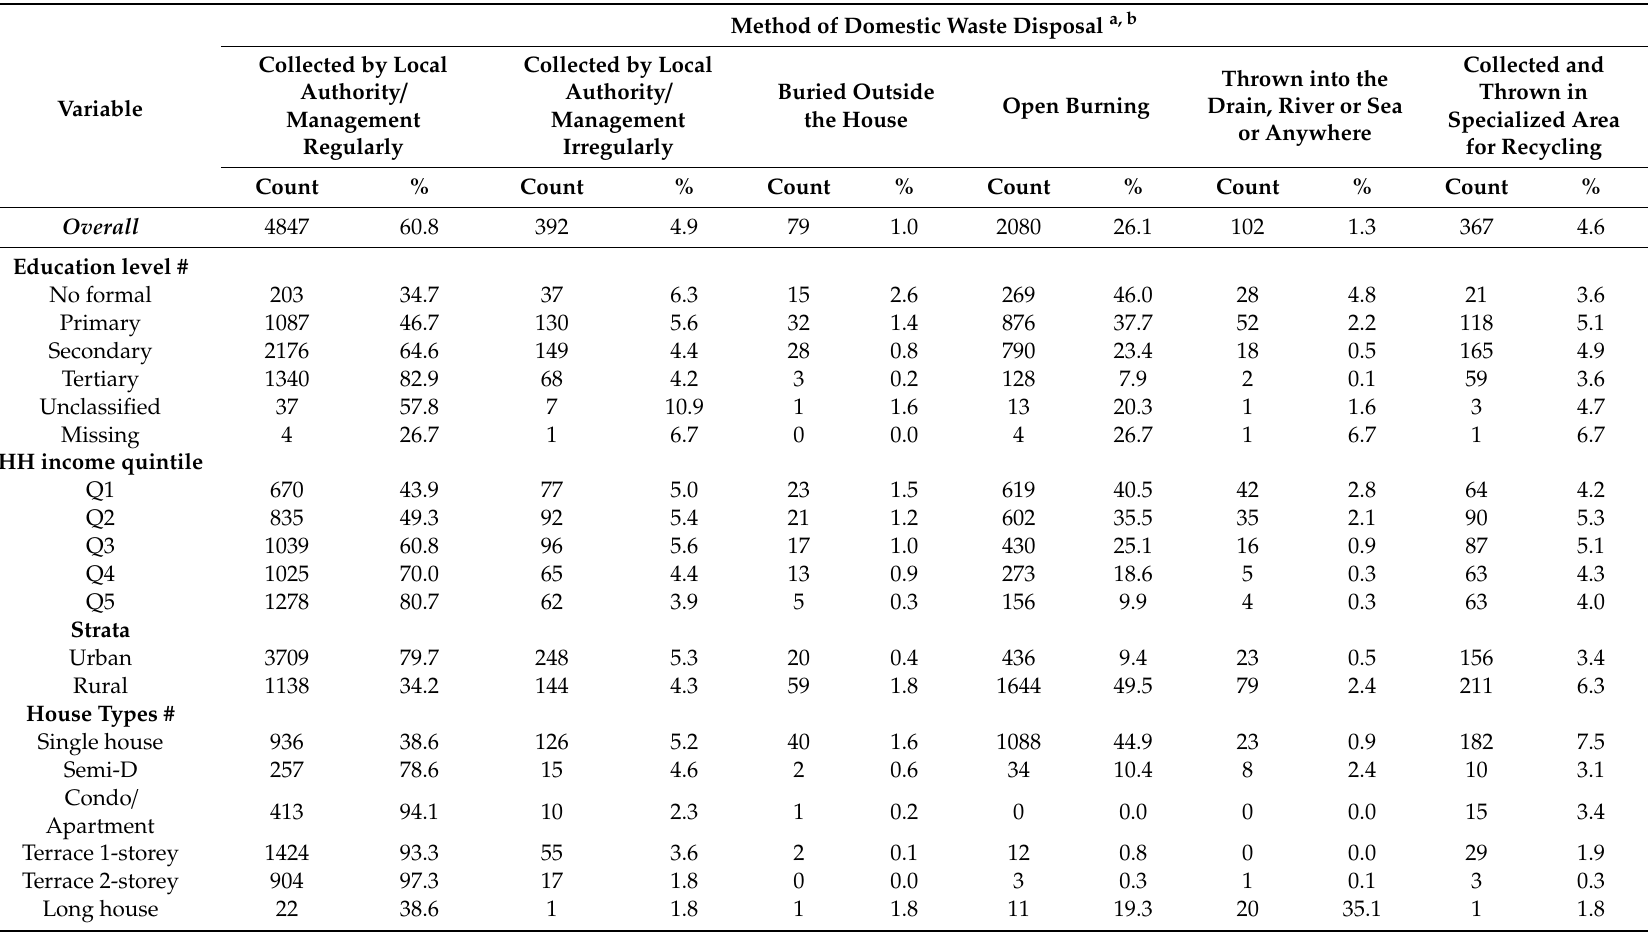
Table A3. Relationships between socio-economic factors and method of domestic waste